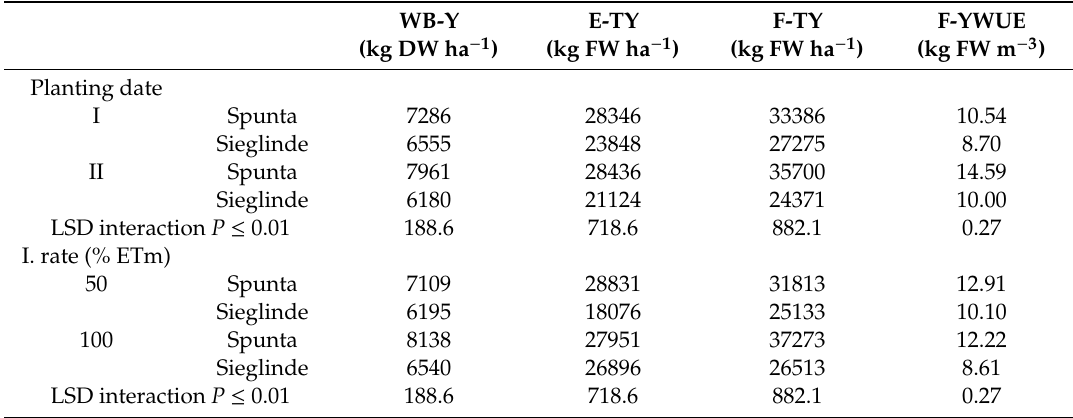
Table 4. Whole dry biomass yield (WB-Y), tuber yield at early harvest (E-TY) and at final harvest (F-TY) and Water Use E ffi ciency for tuber at final harvest (F-YWUE) as a ff ected by interaction ‘Planting date × cultivar’ and ‘Irrigation rate ×